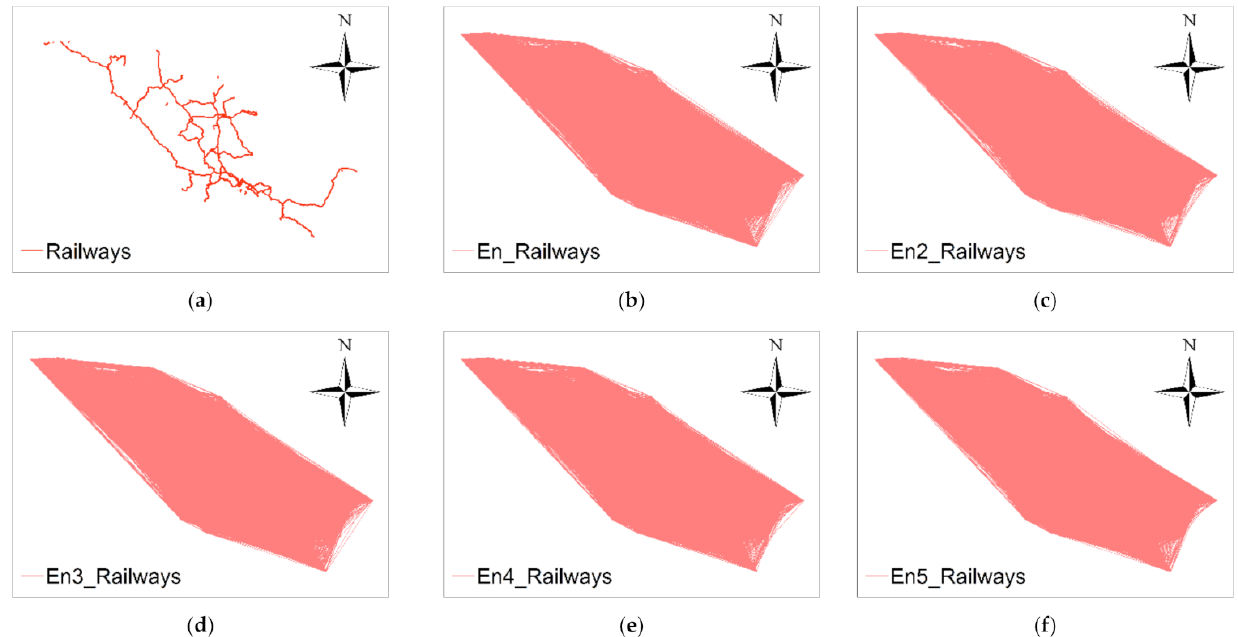
Figure 11. Comparison of different scrambling times. ( a ) The scrambling time is 0; ( b ) the scrambling time is 1; ( c ) the scrambling time is 2; ( d ) the scrambling time is 3; ( e ) the scrambling time is 4; ( f ) the scrambling time is